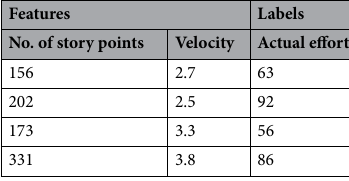
Table 4. Dataset features and labels.